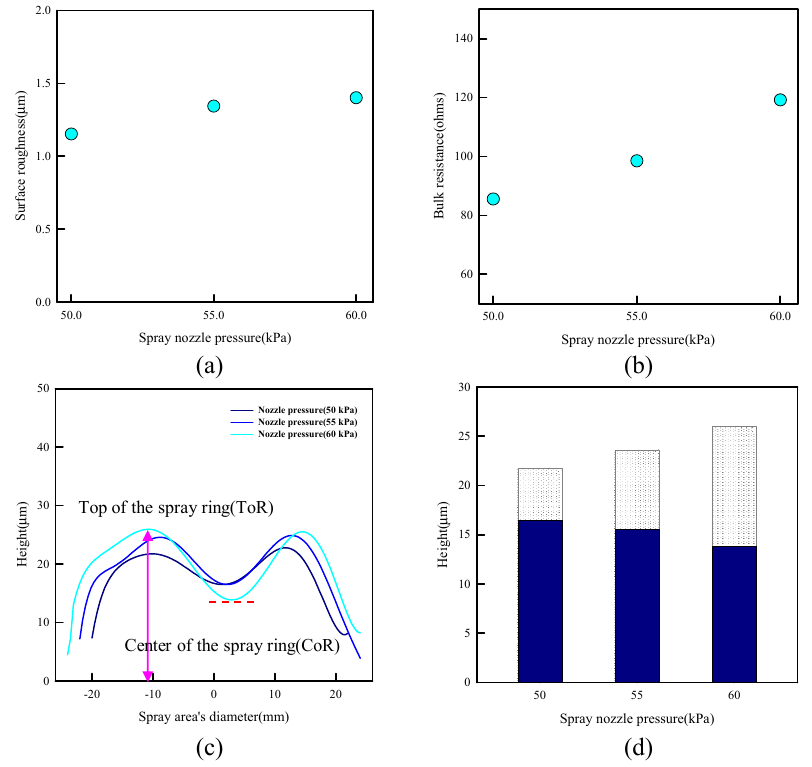
Figure 8. Effect of spray nozzle pressure in ( a ) surface roughness, ( b ) bulk resistance, ( c ) height profile of spray-ring, and ( d ) a comparison of ToR and CoR.